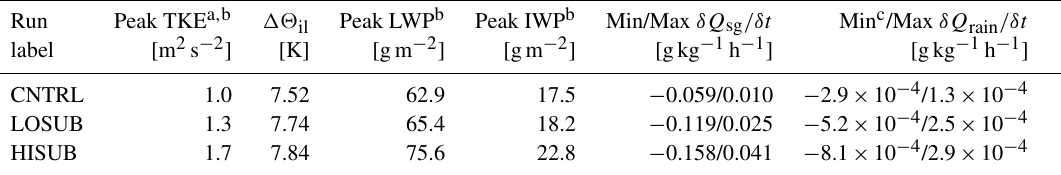
Table 2. Key BL and cloud microphysical parameters affected by large-scale subsidence in test 1. (cid:49)(cid:50) il is calculated across the BL inversion and is listed to illustrate the inversion strength. Peak mass sublimation/evaporation and production rates are quoted at 9h, comparable with Fig. 3.